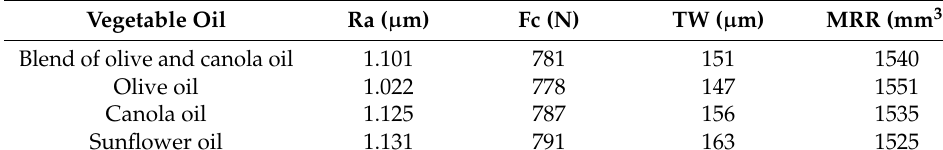
Table 15. Comparison of vegetable oils at optimized levels for responses.